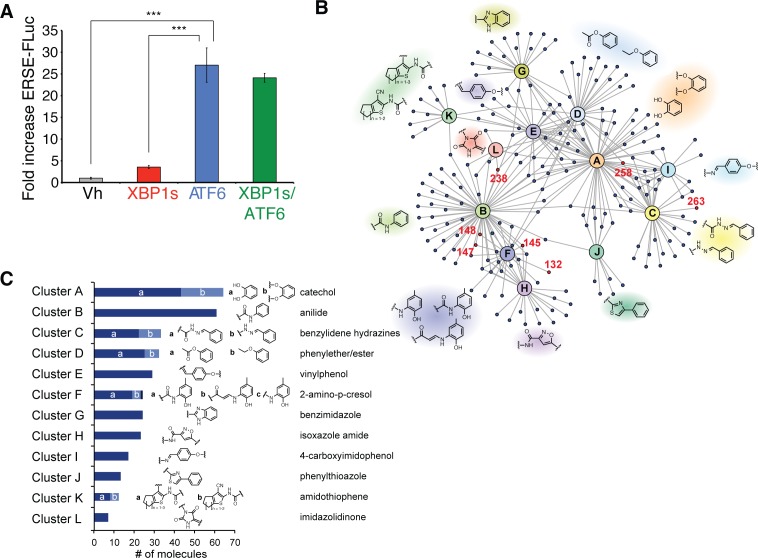
Selectivity of the ERSE-FLuc reporter for the ATF6 UPR arm and highly represented chemical substructures in the top 281 ER proteostasis regulators.(A) Activation of ERSE-FLuc in HEK293DAX cells stably expressing trimethoprim (TMP)-regulated DHFR-ATF6 and doxycycline (dox) inducible XBP1s. Dox (1 µM; 12 h) was added to selectively activate XBP1s (red) and TMP (10 µM; 12 h) was added to activate DHFR-ATF6 (blue), or both were added to activate both XBP1s and ATF6 (green). Error bars show standard error for n = 3. ***p<0.001. (B) Network plot depicting the 12 overrepresented structural moieties (A-K) identified by performing a hierarchical maximum common substructure search of the top 281 small molecule ER proteostasis regulators. The 8 prioritized small molecule ER proteostasis regulators are shown in red. (C) Bar graph showing the prevalence of the 12 most represented chemical moieties identified in the top 281 ER proteostasis regulators. JKlustor was used for clustering and diversity analysis of these molecules, JChem 6.2.2, 2014, ChemAxon (http://www.chemaxon.com). A hierarchical maximum common substructure search of the top 281 small molecule ER proteostasis regulators was carried out using LibraryMCS within JKlustor. A substructure search of the 12 most represented moieties (including derivatives indicated by small letters “a” and “b” was then carried out in the 281 compound set to account for the presence of multiple moieties within the same compound. See the network plot in B for visualization of compounds containing multiple highly represented moieties.